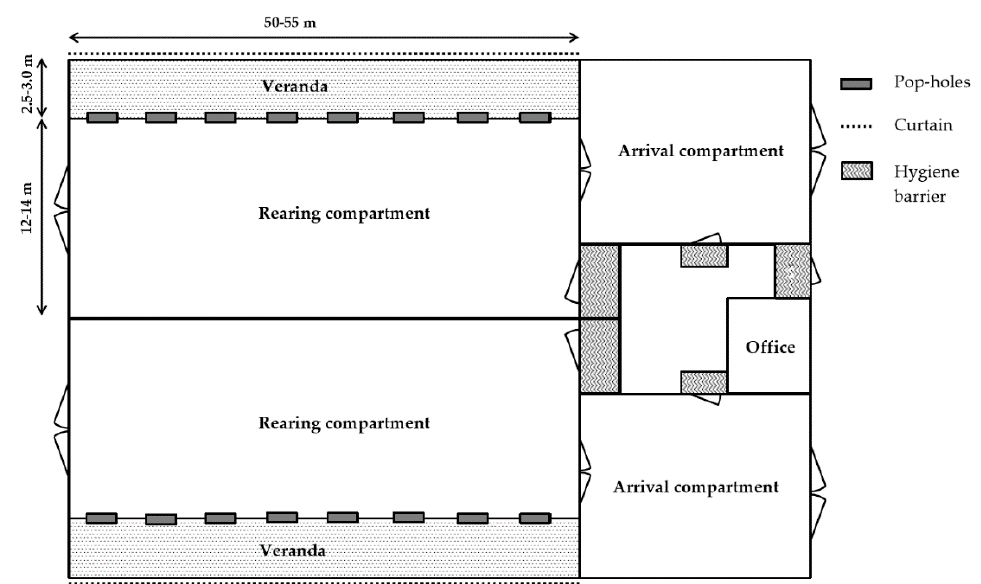
Figure 1. Schematic drawing of typical broiler house with standard rearing compartment dimensions as observed on five Swedish organic farms.